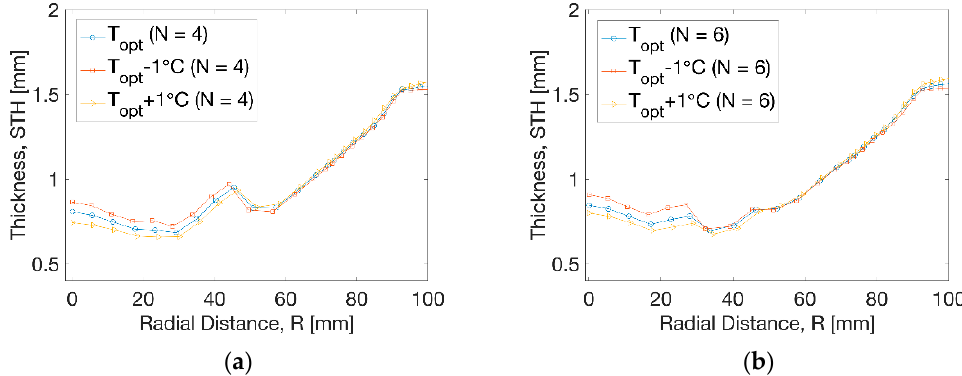
Figure 12. Thickness distribution at different processing conditions. ( a ) N = 4 , ( b ) N = 6.